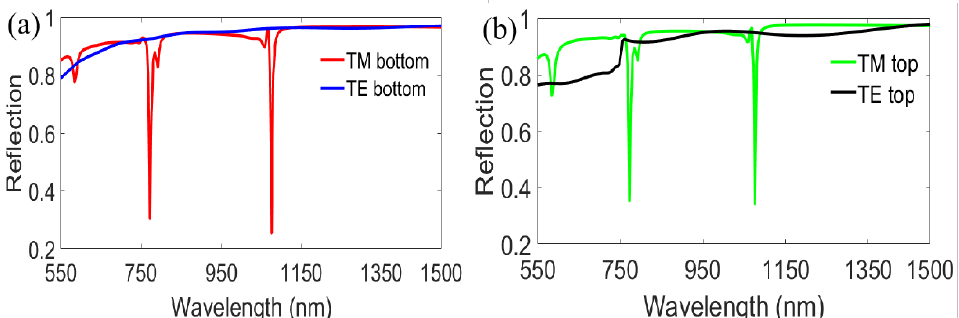
Figure 2. Reflection spectra of nanograting-coated single-layer metal film at an incident angle of 10° for TM and TE polarization: ( a ) Incidence from the bottom; and ( b ) Incidence from the top.